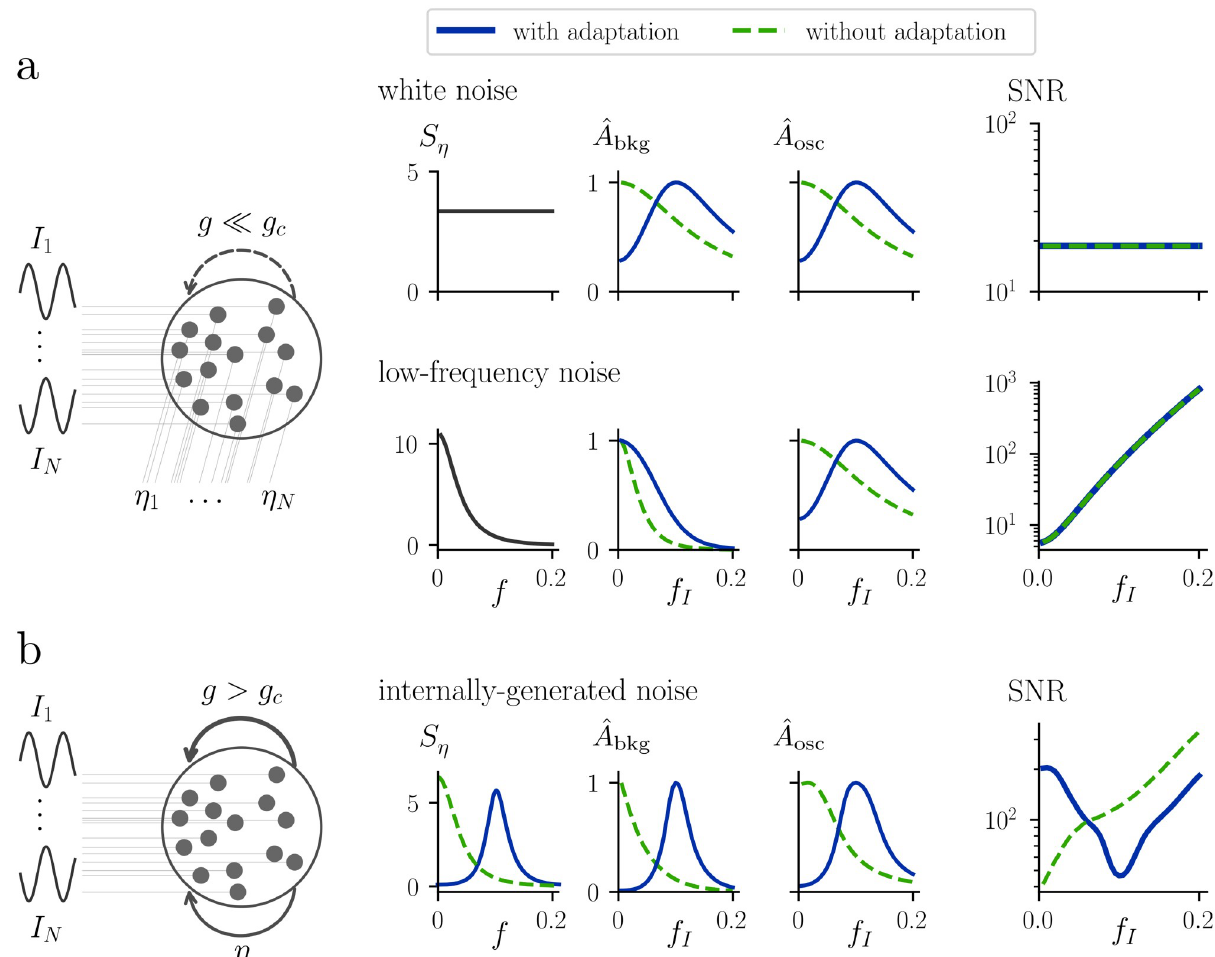
Fig 5. Adaptation shapes the SNR in the chaotic regime. a: For small g , a recurrent network driven by an oscillatory input and external noise can be analyzed in the linear response theory framework. Top row: response of the network to oscillatory drive and independent white noise to each neuron. Bottom row: response of the network to oscillatory drive and independent low-frequency noise to each neuron. For each row, from left to right, we plot the power spectrum of the input noise, the background component of the power spectrum ^ A , the oscillatory component of the power spectrum ^ A , osc osc and the SNR as a function of the driving frequency. The hat over the symbols A bkg and A osc indicates that, to highlight the network shaping, they are normalized to have the same maximum height (equal to one). Notice that, since both signal and noise are shaped in the same way in the linear response framework, the introduction of adaptation does not affect the SNR. b: For large g , the network is subject to internally generated noise and driven by oscillatory input. We plot the same quantities as in panel a . Notice that, due to the nonlinearity of the network, signal and internally-generated noise are shaped in different ways, with the signal being subject to a broader effective filter. As a consequence, the introduction of adaptation in the nonlinear network shapes the SNR by favoring low frequencies. Parameters of the network with adaptation for all panels: γ = 0.25, β = 1 g = 2 g c ( γ , β ) and A I = 0.5.